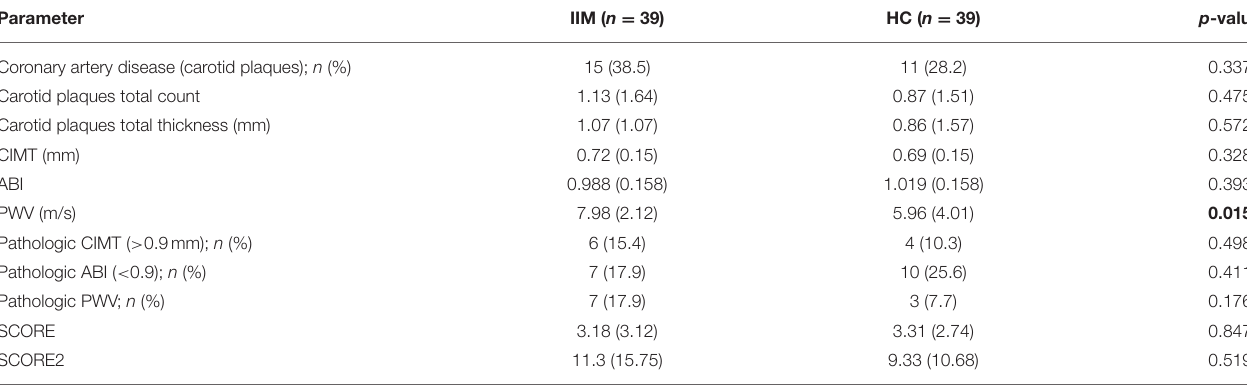
TABLE 3 | Subclinical atherosclerosis (ultrasound and cardiovascular examination) and cardiovascular risk (SCORE, SCORE2) in IIM and HC. Parameter IIM ( n = 39) HC ( n = 39) p -value Coronary artery disease (carotid plaques); n